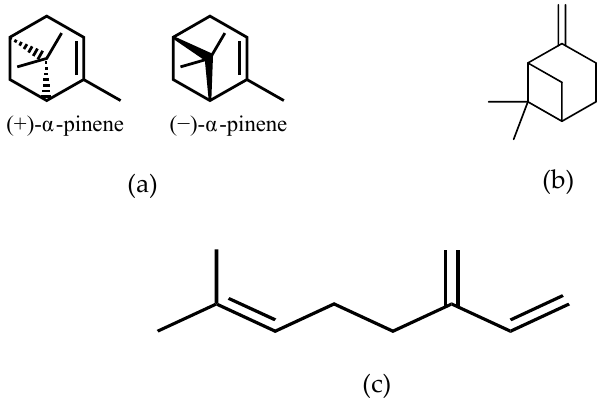
Figure 1. Major monoterpenes of Mastiha. ( a ) isomers of α -pinene; ( b ) β -pinene; ( c ) β -myrcene.